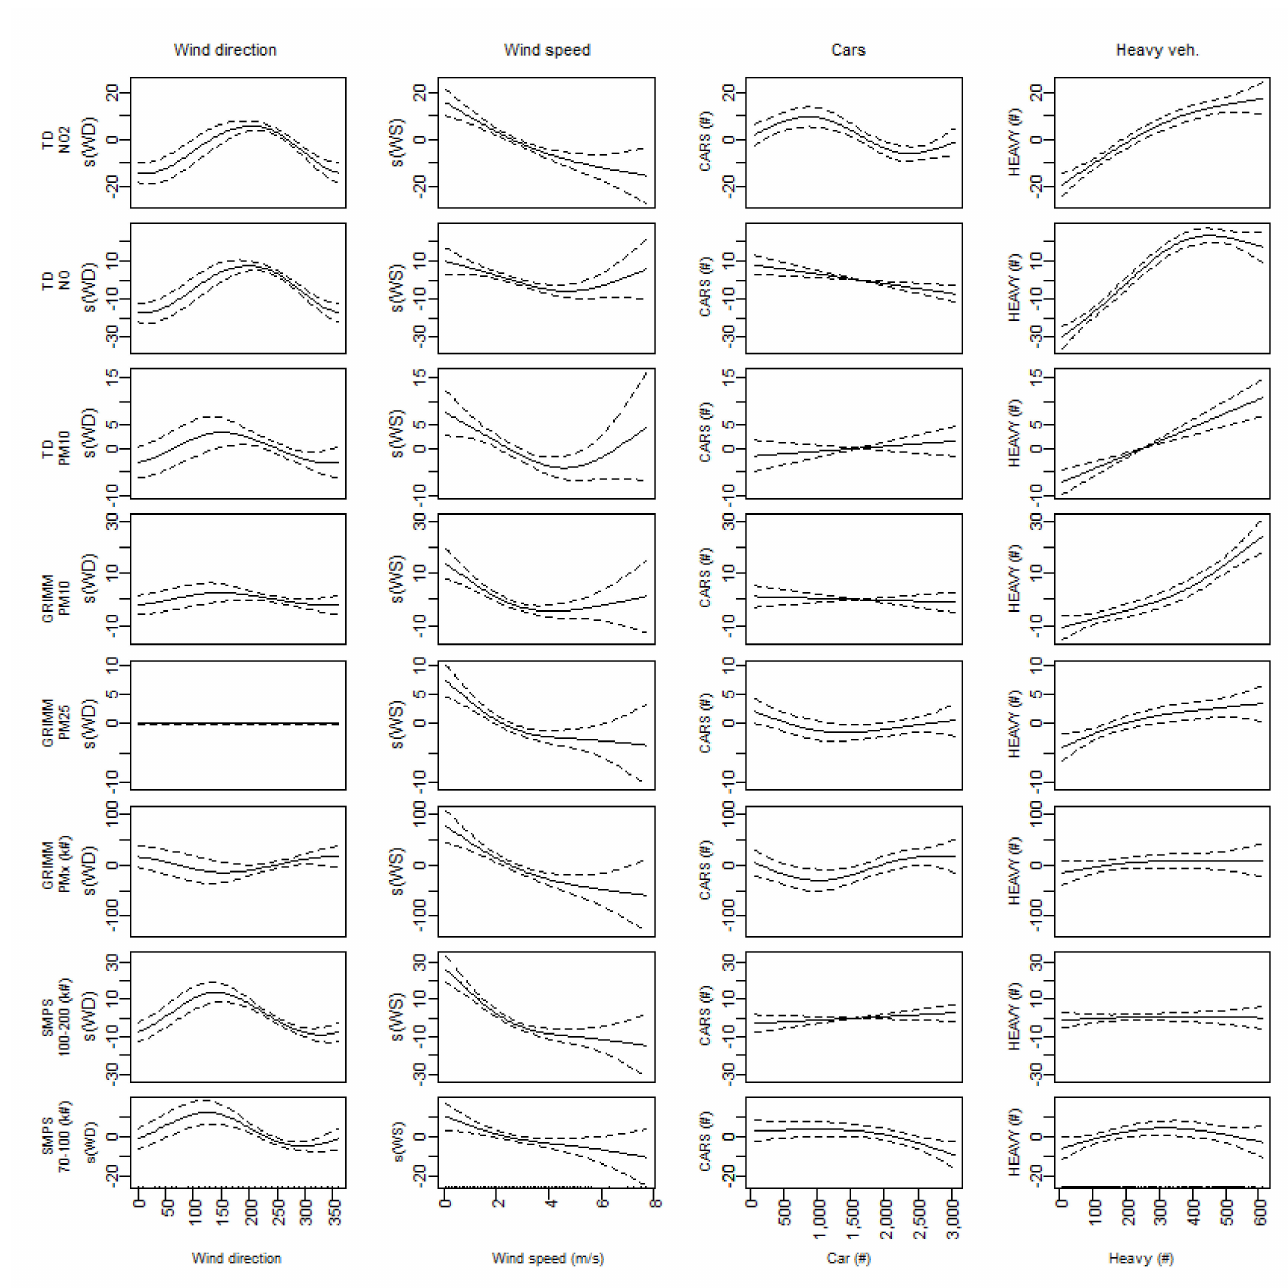
Figure 6. Selection of the basic traffic-air pollution GAM models: NO 2 , NO, PM10 (BAM); PM10, PM2.5 and PMx (GRIMM); UFP count 100–200 nm and 70–100 nm